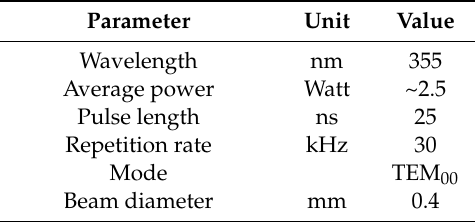
Table 1. 355 nm UV pulsed laser